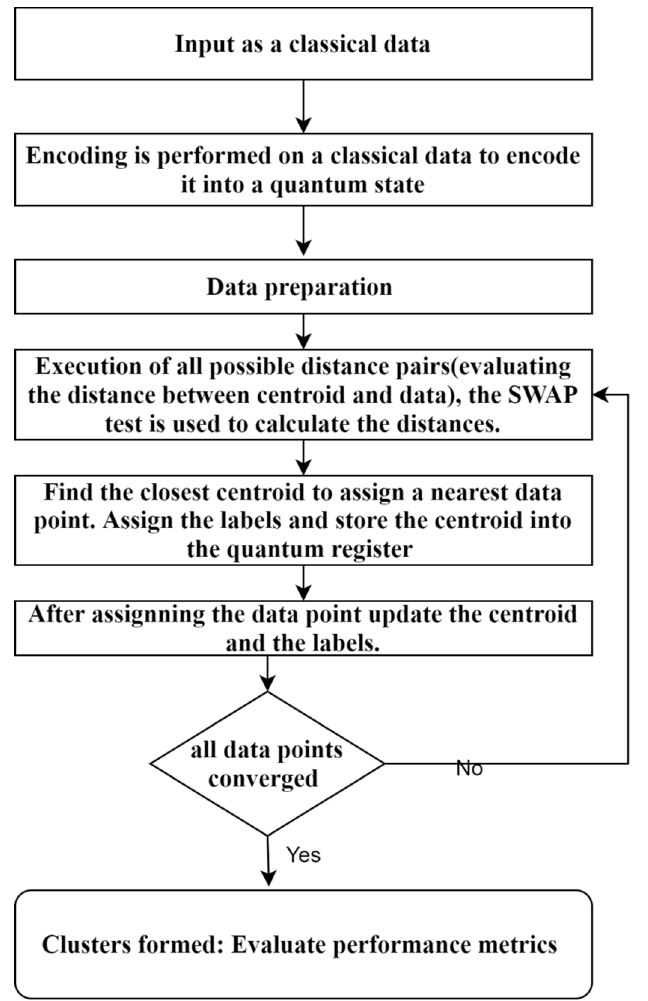
Figure 3. The process flow of the QK-means algorithm. The centroid is the cluster center and datapoints are the input vectors. Table 2. Basic steps for the classical k-means algorithm [30,31].